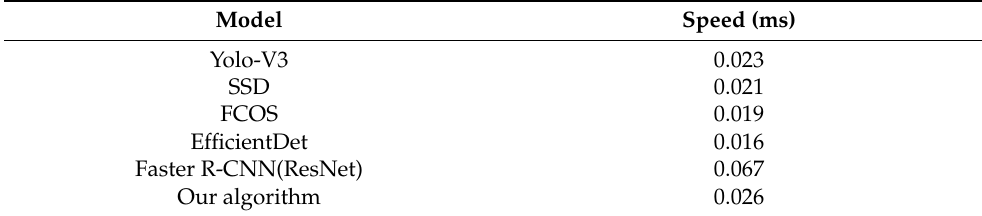
Table 4. Single image running time for each